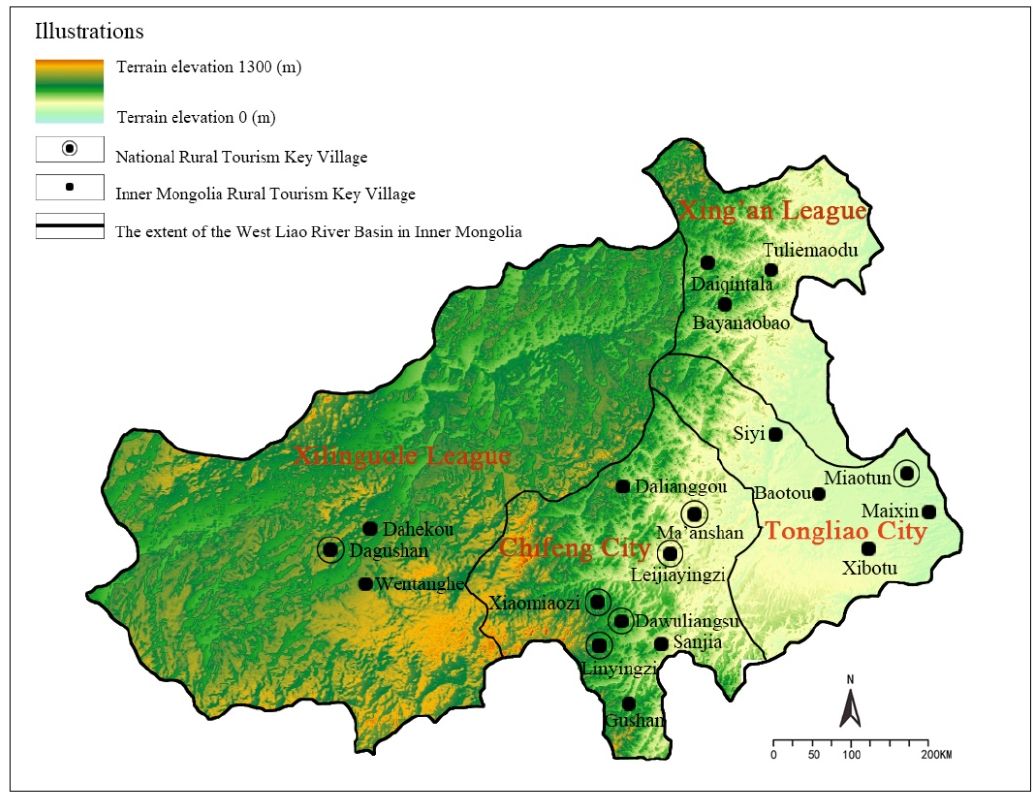
Figure 2. Topographical information and location of rural areas in the Western Liao River Basin, Inner Mongolia.